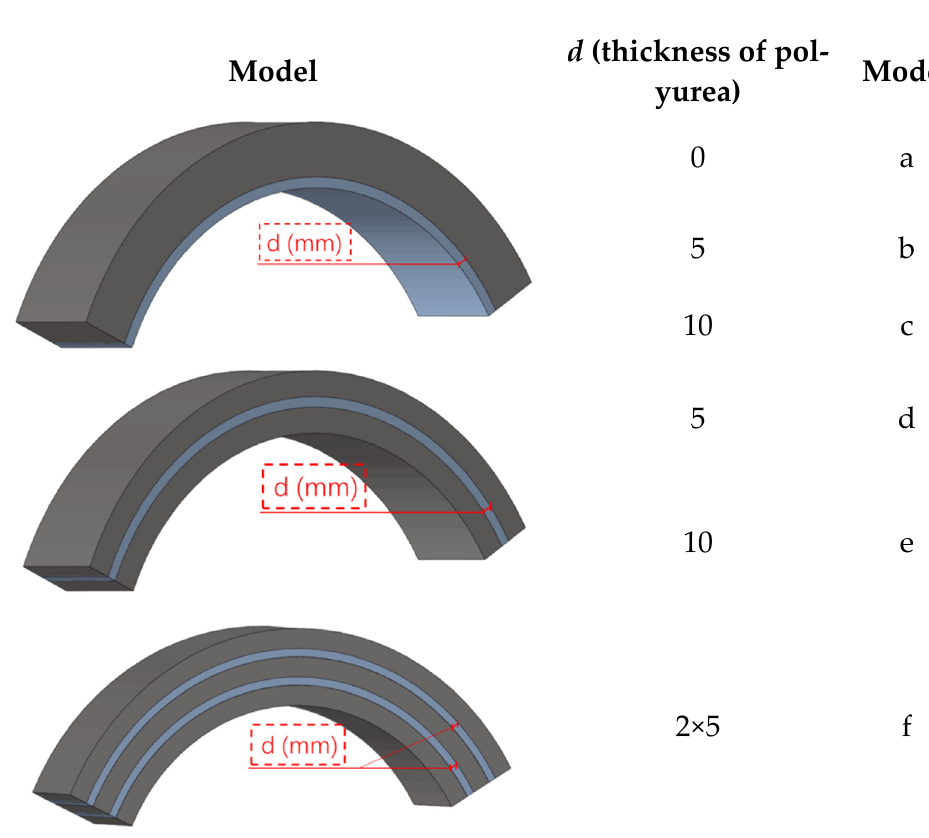
Figure 13. Vibration damping plan for arch structure. ( d is the thickness of polyurea).